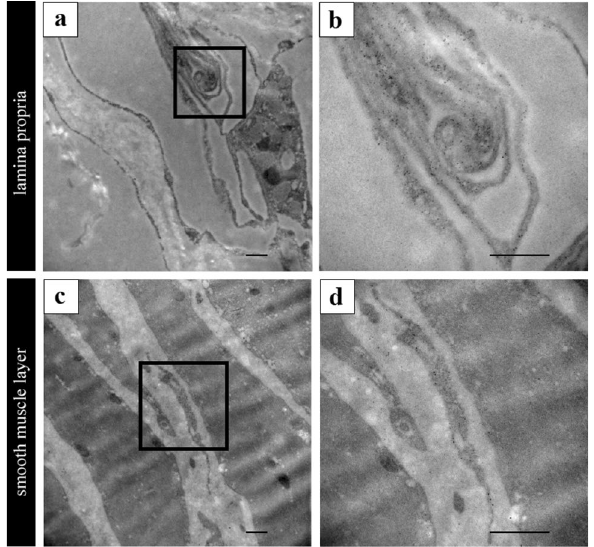
Figure 8. ( a – d ) Immunoelectron microscopy revealed ICs labeled PDGFRα in the lamina propria and smooth muscle layer. ( b ) High magnification of the solid black line square area in ( a ). ( d ) High magnification of the solid black square area in ( c ). A total of 10 nm colloidal golds homogeneously labeled in the cytoplasm of ICs ( b , d ). Scale bars: 2 μm ( a , c ); 500 nm ( b , d